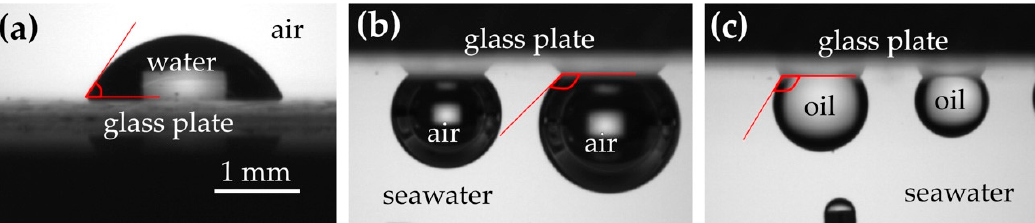
Figure 2. Contact angles (red lines) of a water droplet ( a ), air bubbles ( b ), and oil droplets ( c ) on a glass plate (cover slip).